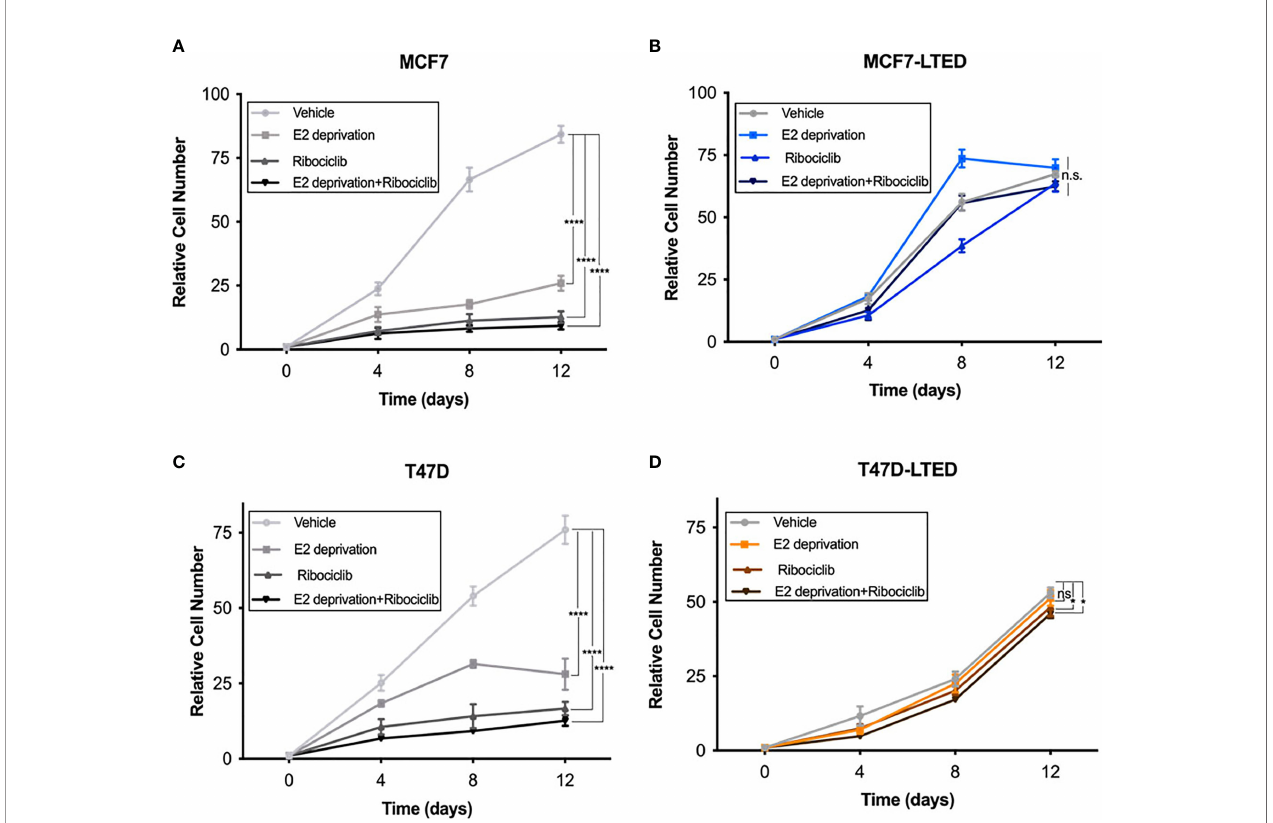
FIGURE 3 | LTED cells are resistant to the combination of antiestrogens and CDK4/6 inhibitors. (A – D) The growth rates of parental cells (MCF7 and T47D) and their derivatives (MCF7-LTED and T47D-LTED) treated with vehicle, E2 deprivation, 500nM ribociclib or the combination of E2 deprivation and ribociclib and cell number were measured for 12 days and compared to time=0 (start of treatment). Cells were suspended in PBS and counted by a Beckman Coulter Counter. Points represent the mean±SE of relative number (normalized to t=0) for a single representative experiment performed in triplicate. *p < 0.05, ****p < 0.0001 and ns is not signi fi cant (ANOVA) for relative cell number with indicated treatment conditions at 12 days for respective cell lines. Data presented here is representation of three independent experiments